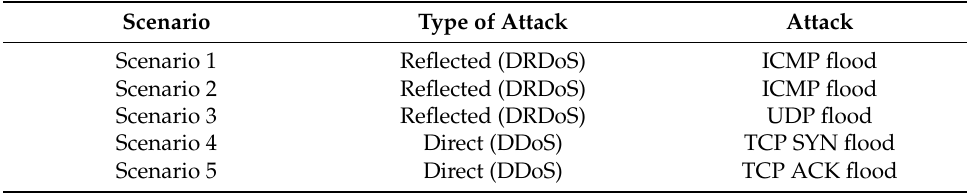
Table 3. A brief overview of the types of attacks that were used in each